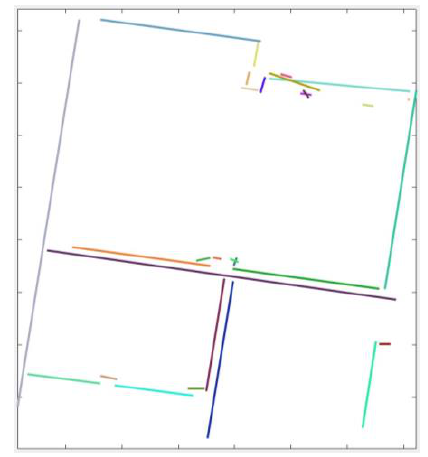
Figure 9. Extracted linear features of the optimal section.